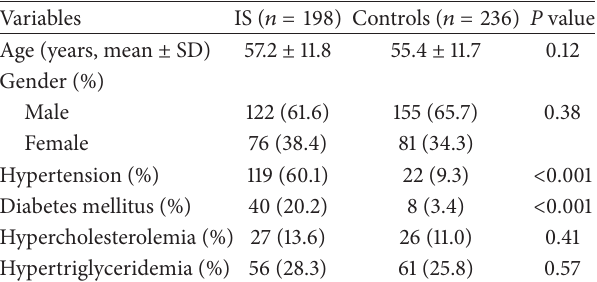
Table 1: Characteristics of study subjects. Table 2: Genotype and allele distributions of the IL-16 gene polymorphisms in IS cases and controls.